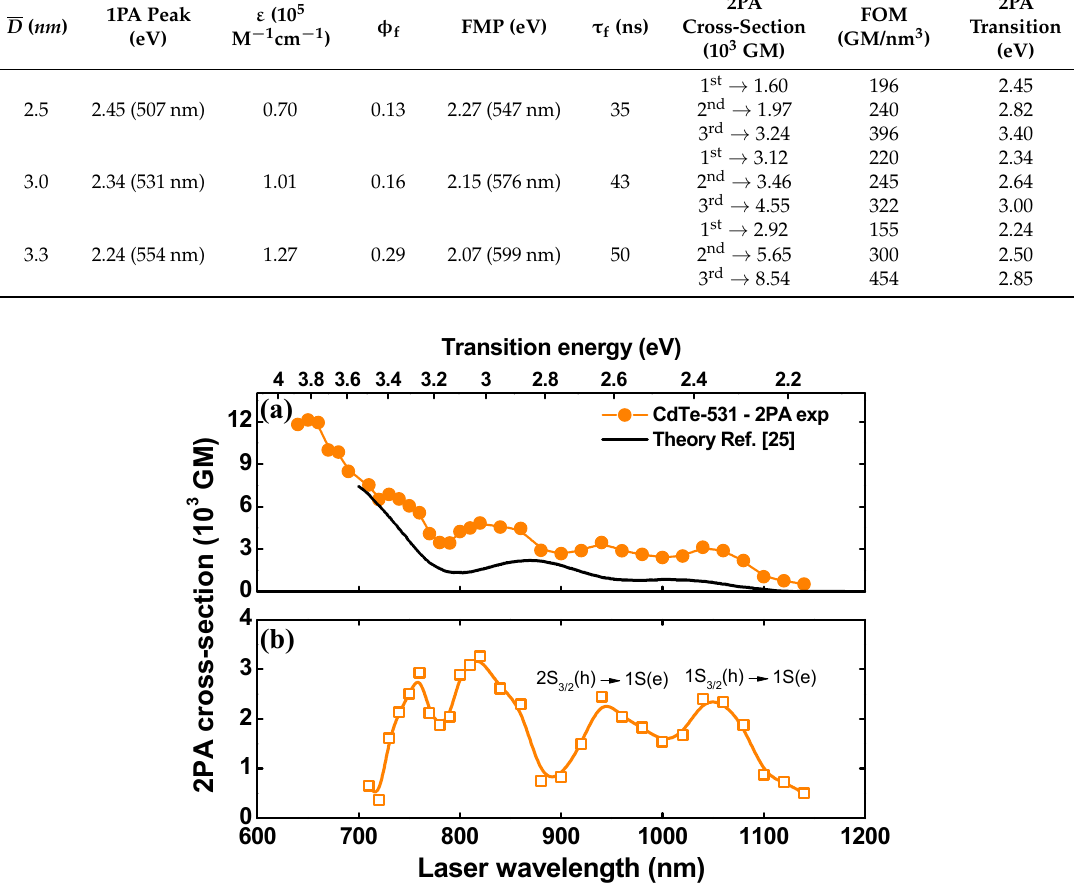
Figure 3. ( a ) Experimental (dots) and theoretical (solid line, data from the Ref. [25]) 2PA spectrum for CdTe-GSH QDs (CdTe-531); ( b ) The difference between the experimental and theoretical 2PA spectrum reported in part ( a ).